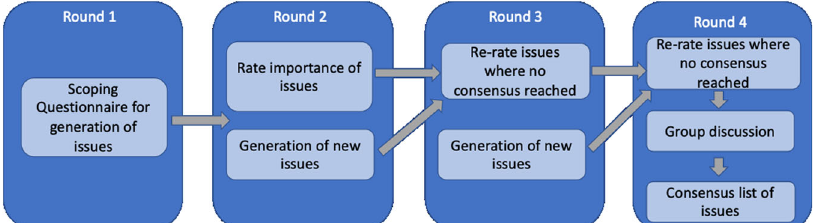
Fig. 2 Structure of Delphi exercise 32 . Round 1 consisted of a scoping questionnaire. Rounds 2 and 3 consisted of voting questionnaires. Round 4 consisted of a fi nal online